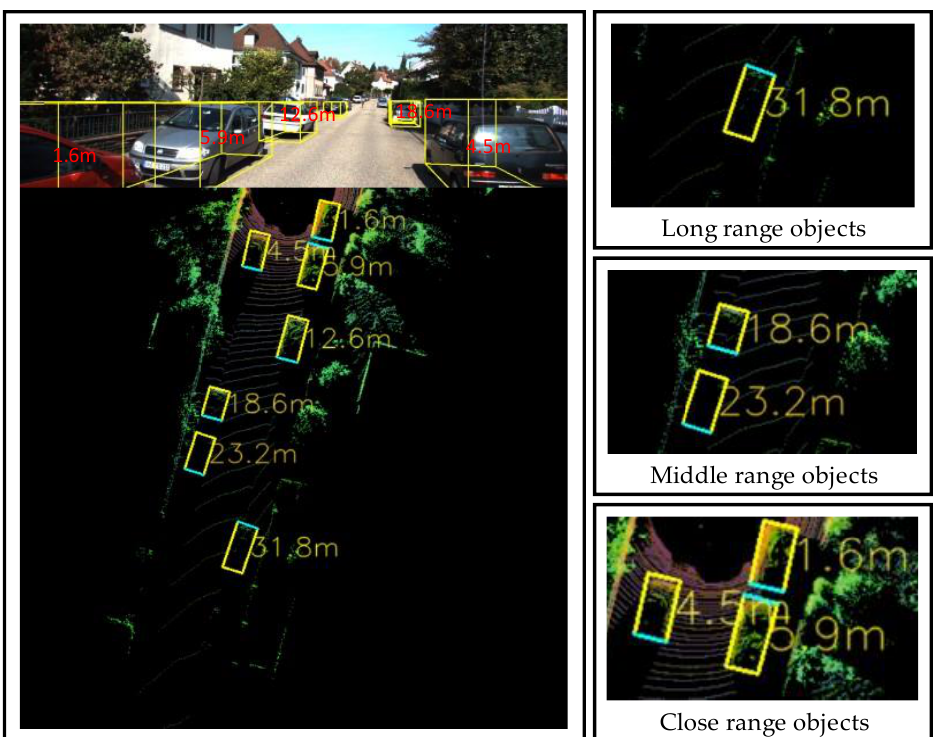
Figure 5 . Distance estimation results (in meters) displayed onto the BEV map. Table 1. Quantitative results of our distance estimation method for the four regression evaluation metrics in terms of various distances ranges.